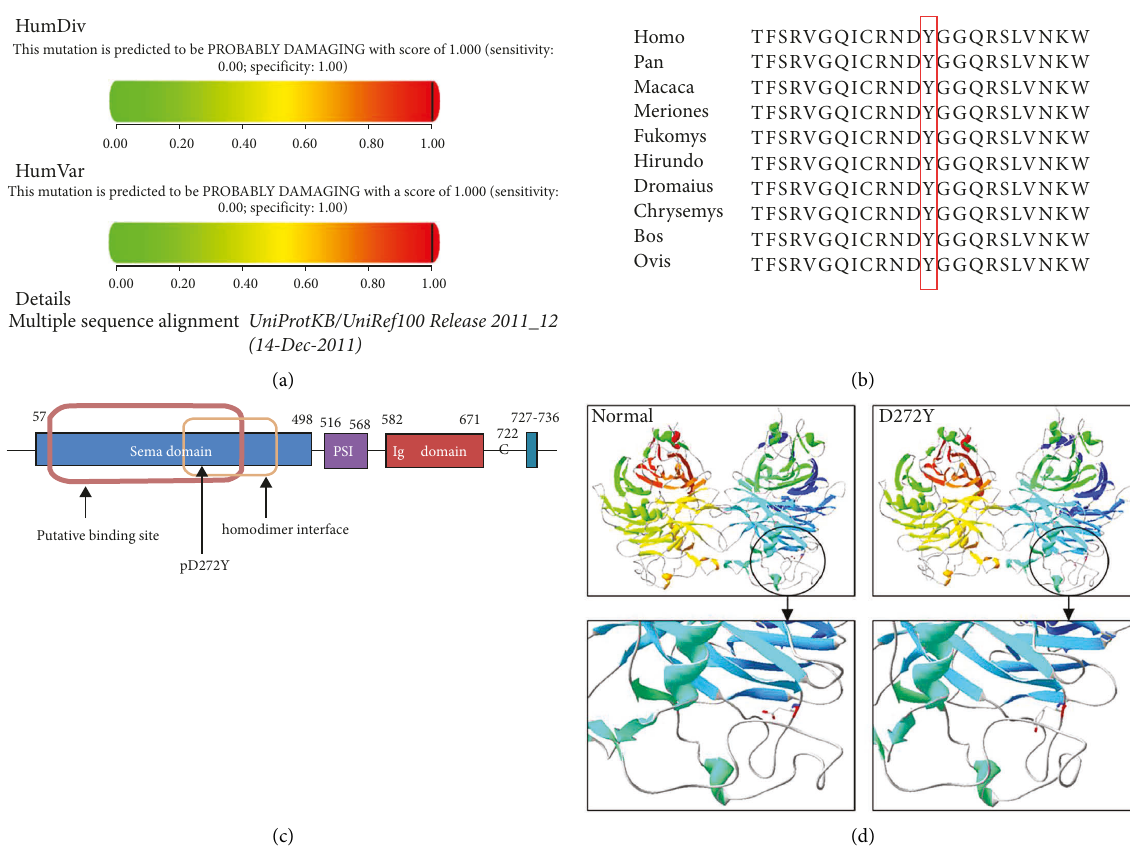
Figure 1: Bioinformatic analysis, domains and protein structure prediction of the novel variant in the SEMA3A gene. (a) Score of the novel damaging variant c.814G > T (p.D272Y) in Polyphen v.2. (b) Cross-species conservation of SEMA3A around p.D272 is displayed. (c) The structure domains of SEMA3A. The arrow below the domains on the left indicates the putative plexin binding region, the right is the homodimer interface where polypeptide binds, and the novel variant site of SEMA3A is located at the middle. (d) Protein structure prediction of wild-type and mutant SEMA3A